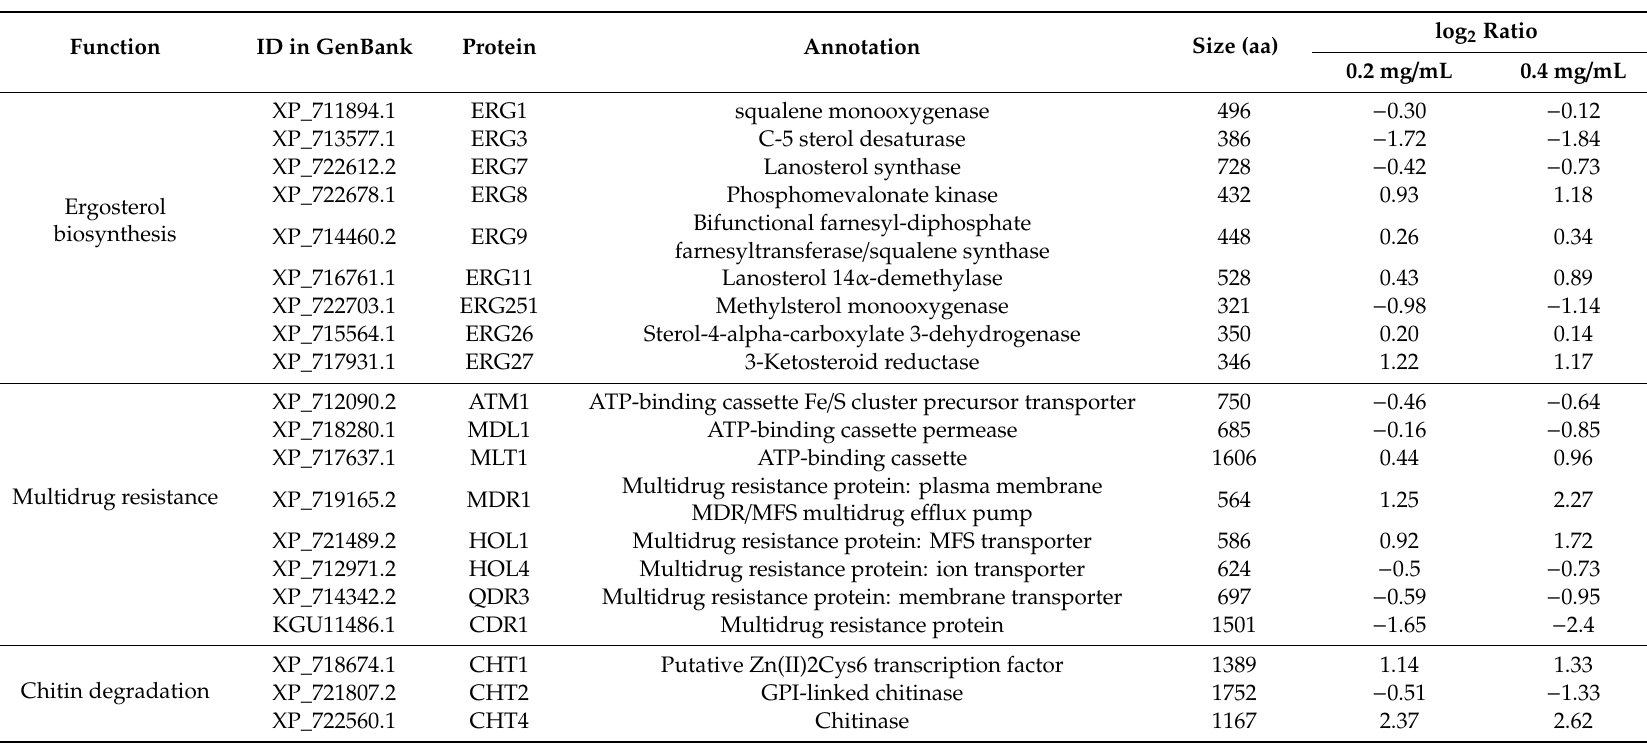
Table 1. Response to SSE of the genes involved in ergosterol biosynthesis, multidrug resistance and chitin degradation of C. albicans in a dose-dependent manner. Function